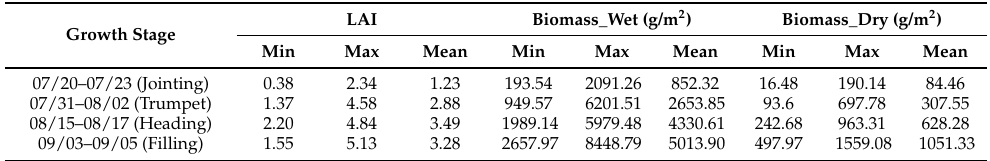
Table 2. Statistics of the in situ LAI and biomass